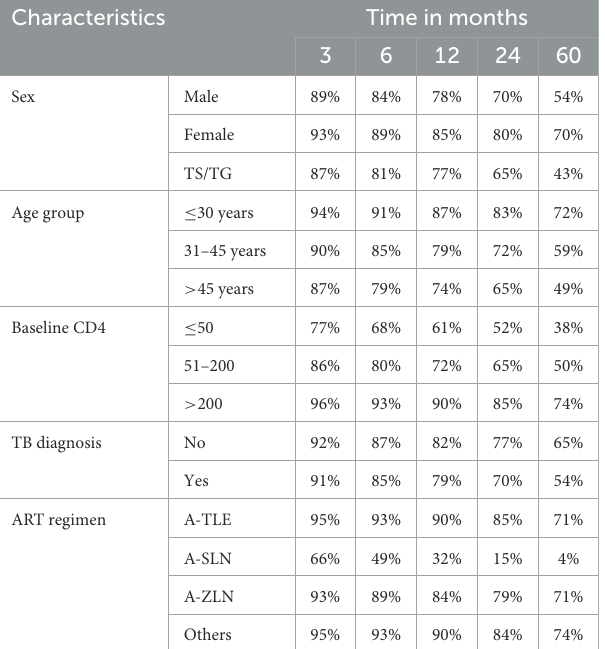
TABLE 5 Survival probabilities according to risk factors at a different point in time.